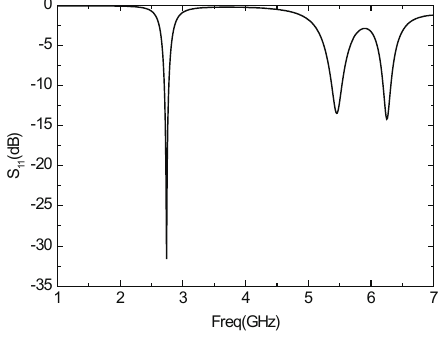
Figure 15. Parameter S 11 of the antenna without a